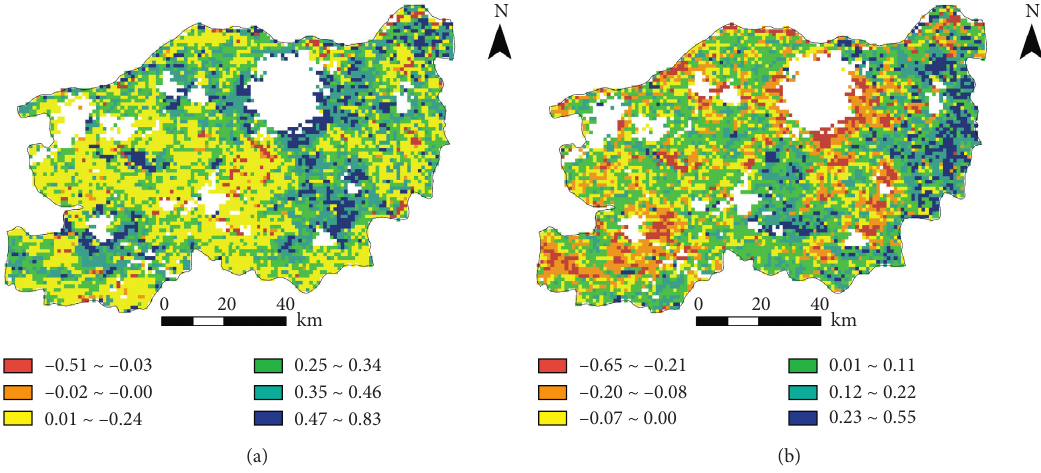
Figure 4: Spatial distribution of the correlation coefficients between NPP and precipitation (a) and temperature